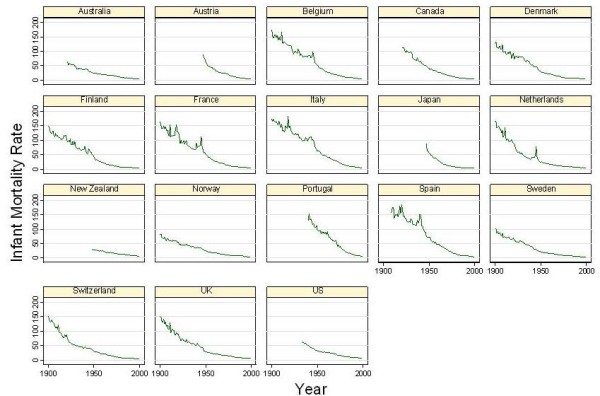
20th Century Infant Mortality Decline: Graphs by Country.